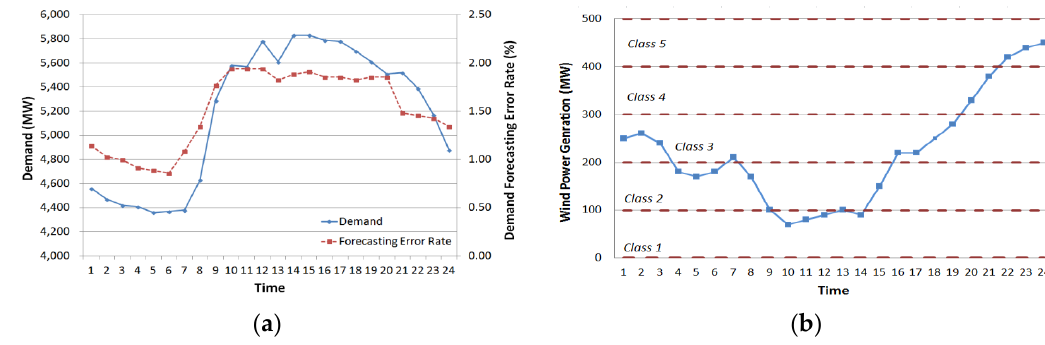
Figure 2. Forecast demand and wind power generation used in the case study: ( a ) Forecast demand (labeled with left y -axis) and the error in the forecast demand (labeled with right y -axis) based on data for summer 2012 in Korea; ( b ) Hourly forecast wind power generation in a typical day and for Classes 1–5.